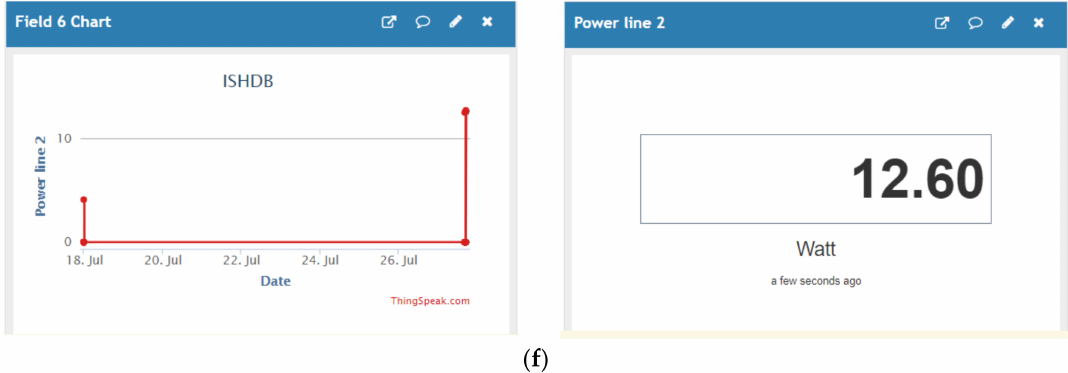
Figure 8. ( a ) Voltage of line 1 in field 1, ( b ) Current of line 1 in field 2, ( c ) Power of line 1 in field 3, ( d ) Voltage of line 2 in field 4, ( e ) Current of line 2 in field 5, and ( f ) Power of line 2 in field 6.